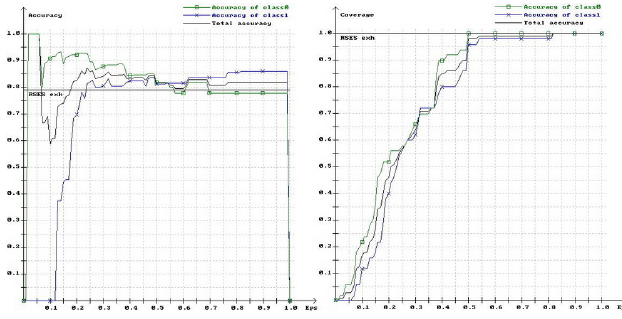
Fig. 1. Results for voting by granules of training